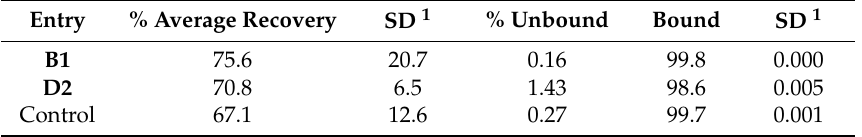
Table 2. Protein binding of B1 , D2 , and control peptide after 4 h incubation in